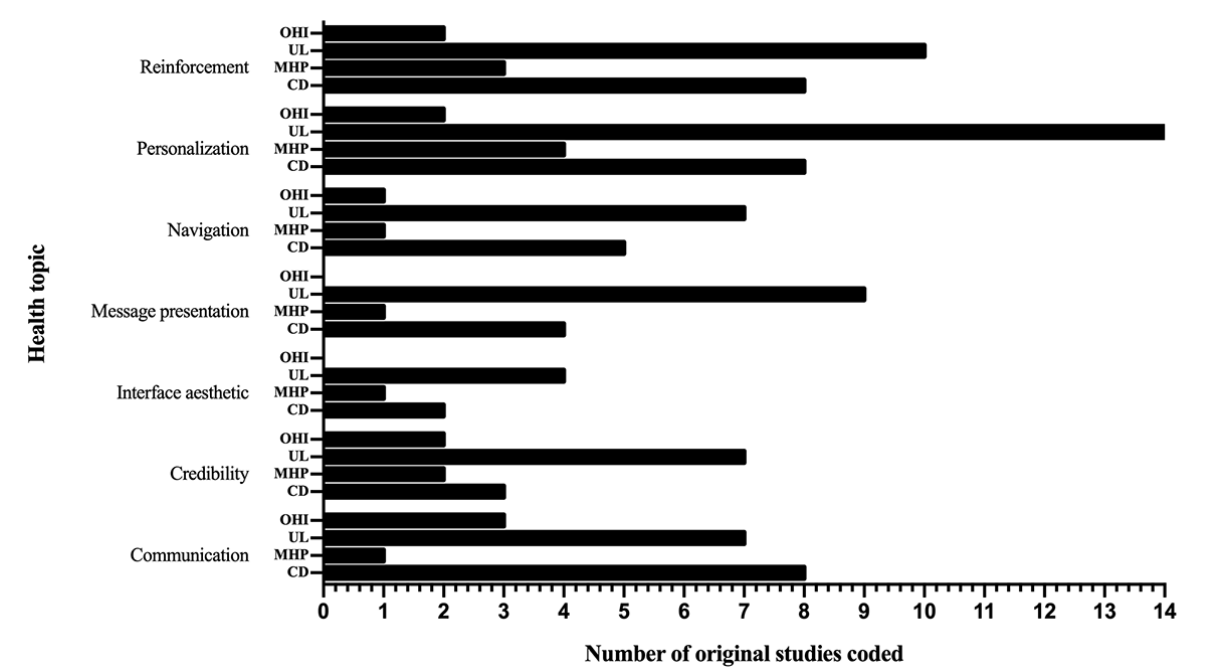
Figure 3. Comparison of analytical themes in different health topics. OHI: other health issues; UL: unhealthy lifestyle; MHP: mental health problem; CD: chronic